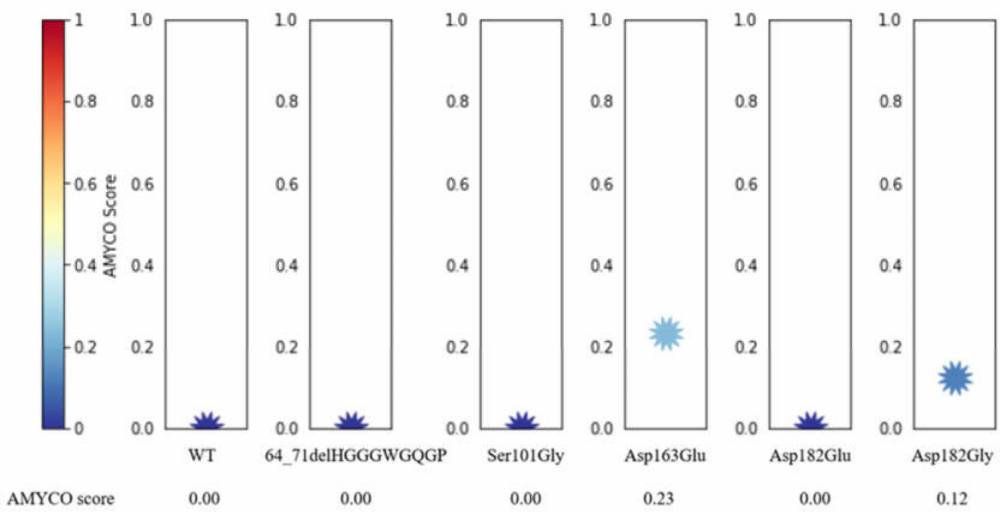
Figure 7. Prediction of aggregation propensity according to alleles of dog prion protein (PrP) polymorphisms. The impact of polymorphisms on the aggregation propensity of dog PrP was evaluated as values from 0.0 to 1.0 by AMYCO analysis. AMYCO scores < 0.45 and > 0.78 indicate low and high aggregation propensities of the protein,